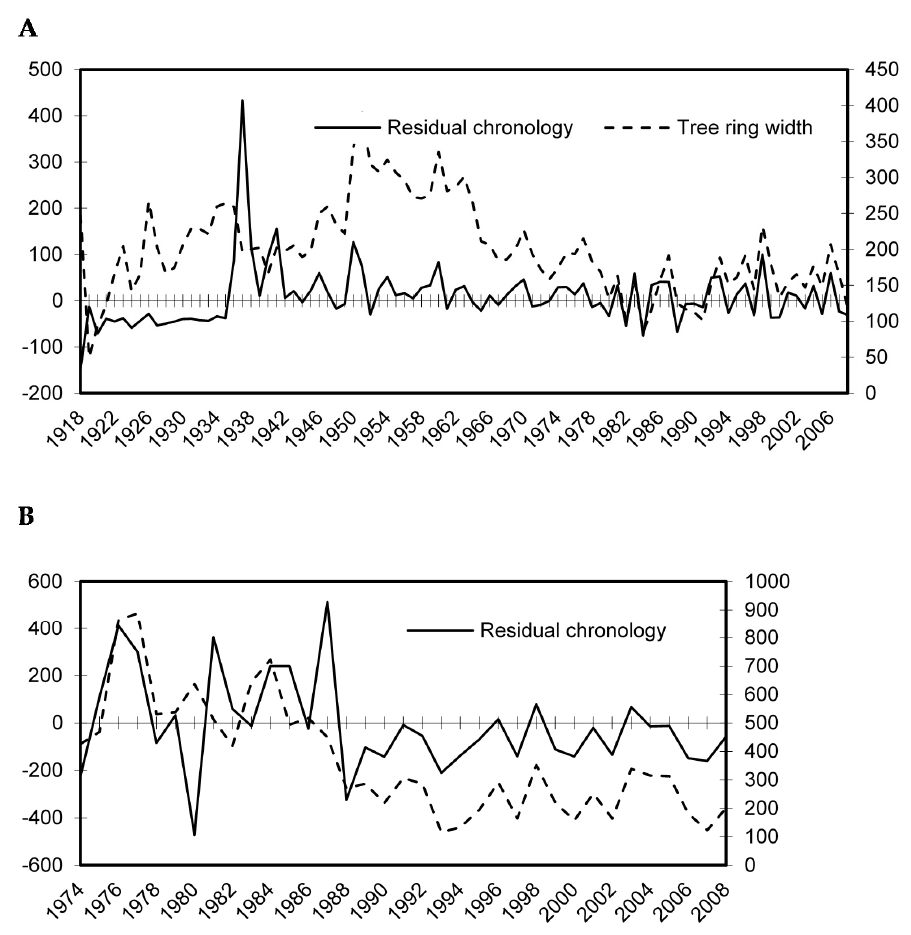
Figure 3. Mean annual cork oak tree ring measurements before standardization (raw tree ring width), and after standardization (tree ring residues) in the mature stand MS ( A ) and in the young stand YS ( B ).